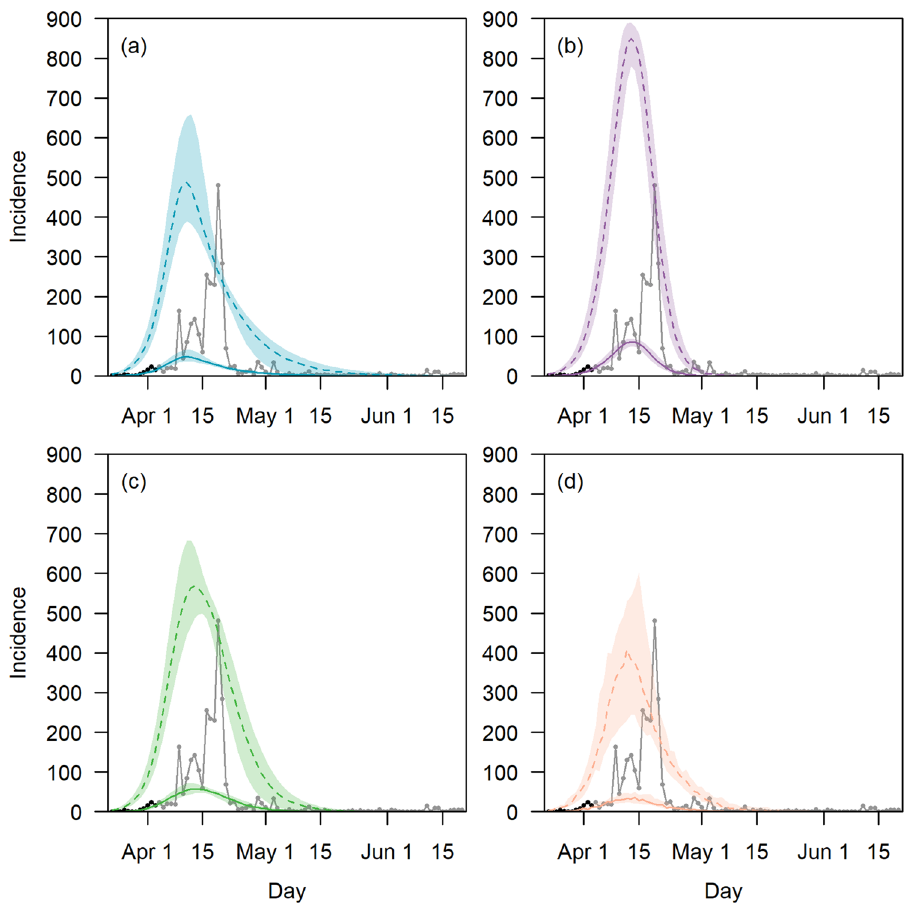
Figure 2. Outbreak trajectory in symptomatic cases who sought for medical treatment (solid line) and in all cases (dashed lines) with 95% confidence intervals (shaded area) by scenario ( a ) current outbreak scenario ( b ) baseline scenario, ( c ) enhanced response and social distancing scenario, ( d ) modified dormitory settings scenario. Observed symptomatic cases with onset on or before 3 Apr 2020 (black dots, up to day 12 of the outbreak) were used for model fitting. Cases after 3 Apr 2020 (grey dots and lines) were plotted based notification dates if onset dates were not available and were not used for model fitting due to incomplete information on onset dates for some of the symptomatic